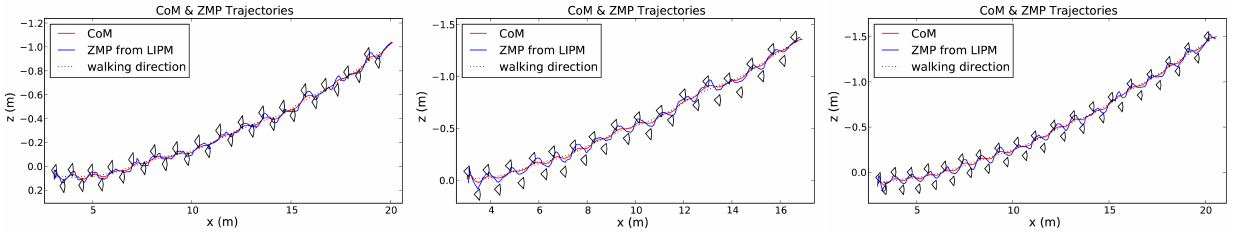
Figure 21. ZMP/CoP, COM trajectories and feet position during the support phase: normal walking (left), right knee immobilization (center) and ski boot on right foot (right)